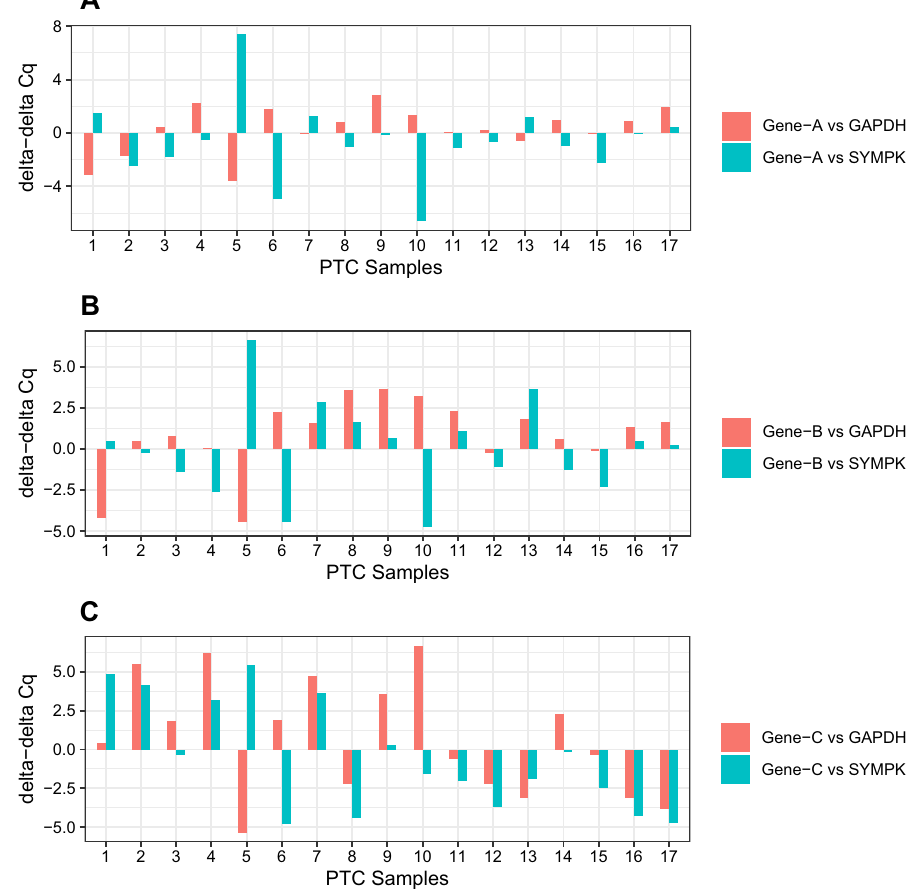
Figure 2. PTC tissues were compared to their adjacent normal tissues. Each target gene (gene A, gene B and gene C) was normalized once against " GAPDH " (red bands) and also a second time against " SYMPK " (blue bands). For Gene-A, 4 out of 17 samples (samples 2, 7, 16, and 17) show the same pattern after normalization against two different reference genes, while 13 samples (e.g. samples 1, 5, 6 and 10) show contradiction. For gene-B, 9 out of 17 samples and for gene-C, 5 out of 17 samples show contradiction. Positive and negative delta- delta Cq ratios respectively represent a target gene in PTC tissues that is down-regulated or over-expressed. Y-axis present deltadelta Cq ratios and X-axis show PTC